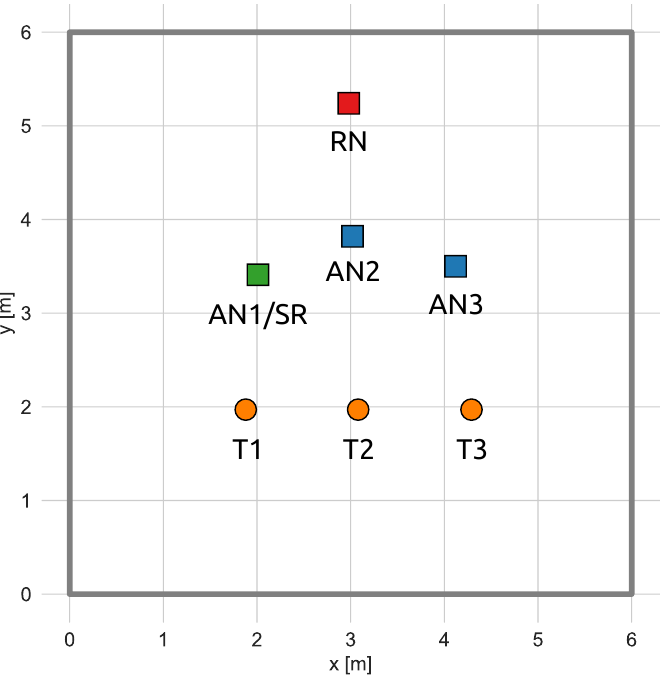
Figure 6. Test setup for the synchronization method